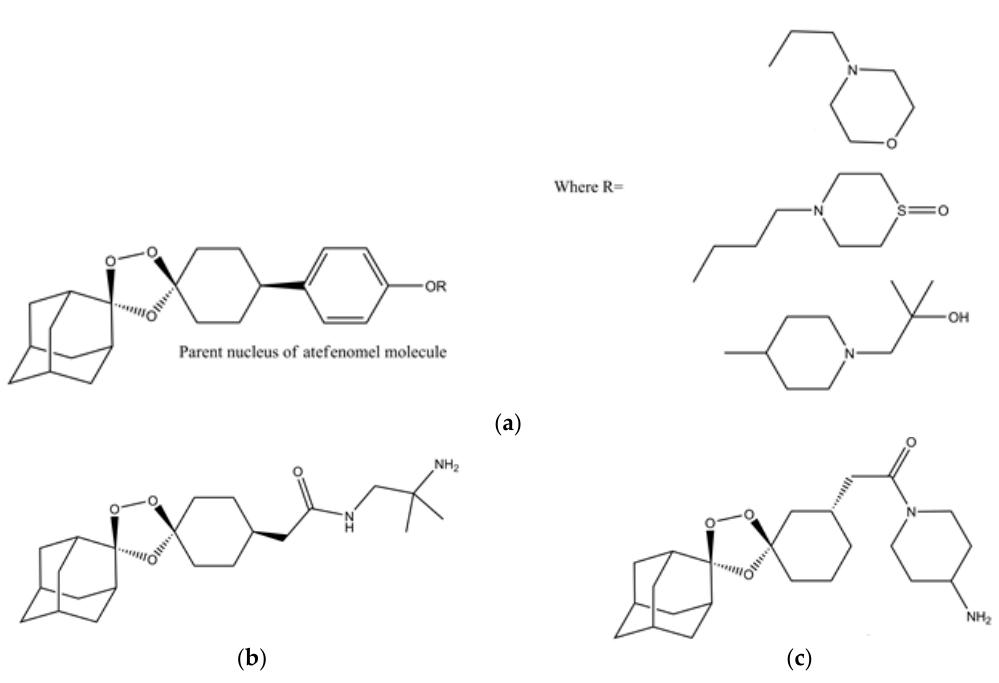
Figure 7. ( a ) Chemical structure of artefenomel and its optimized tertiary amine analogues [105]; ( b ) arterolane; ( c ) arterolane analogue that has higher antiplasmodial activity than arterolane [115].